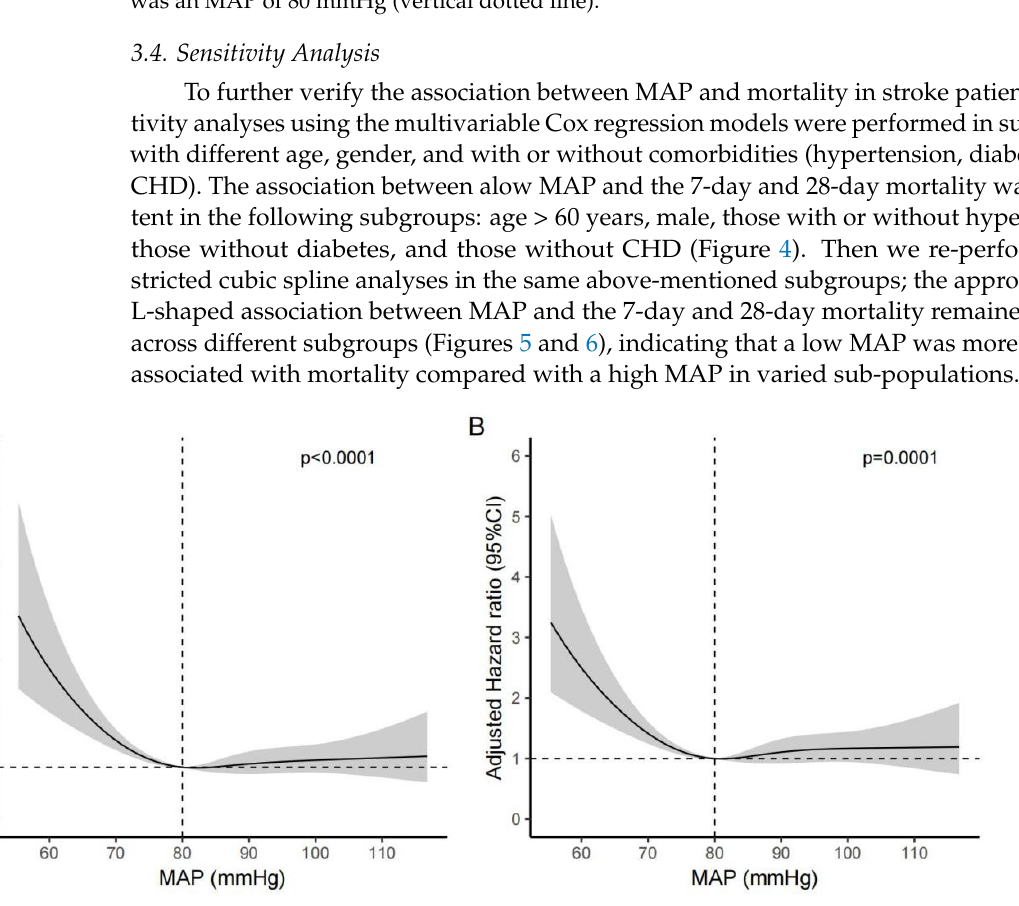
Figure 3. Adjusted non-linear association between MAP and the 7-day mortality ( A ) and 28-day mortality ( B ) in patients with acute stroke. All the covariates were included for adjustment.